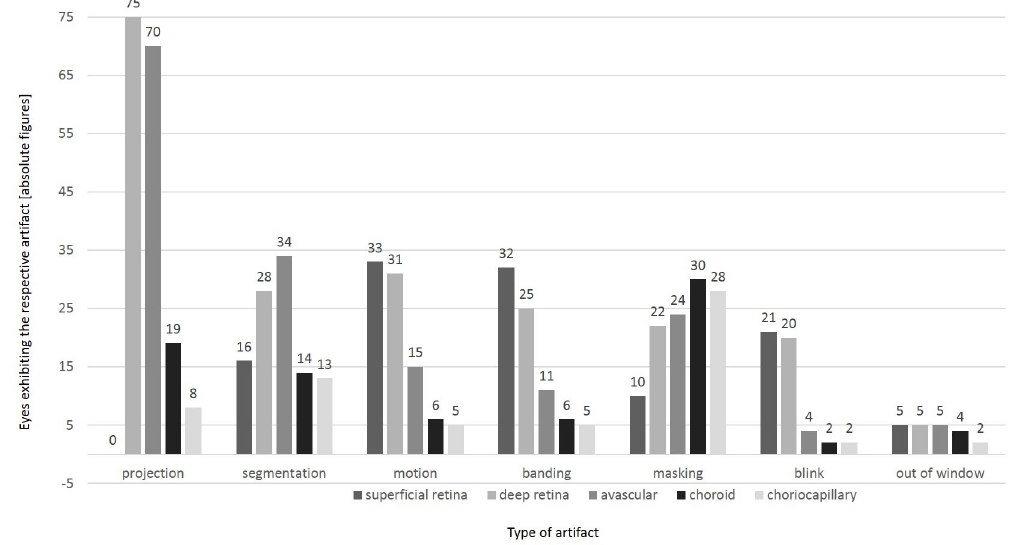
Fig 3. Frequencies of various artifacts in different segmentations of the OCTA scans. Overall, the interpretability of the OCTA images was graded sufficient in 25% of assessments (19/75, 95% confidence interval (CI): 16%-37%) and excellent in 65% (49/75, 95% CI: 53%-76%), adding up to 91% of OCTA assessments deemed of an acceptable quality allowing for clinical interpretation (68/75, 95% CI: 82%-96%). Also, the presence of macular edema was associated with poorer interpretability: While 85.7% of OCTA images of eyes without ME were excellently interpretable, 76.9% of OCTA imaging results with a ME < 400 μ m and 33.3% with a ME > 400 μ m (p < 0.01; Fisher‘s exact test) were deemed of sufficient quality for clinical